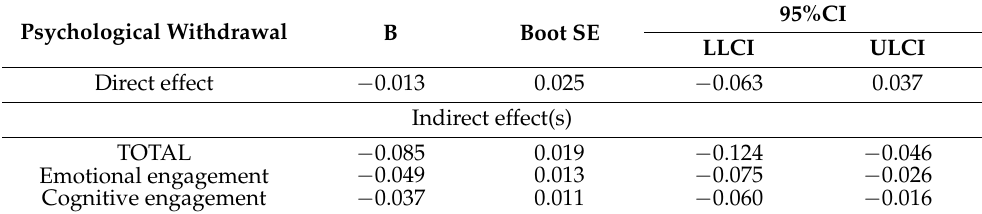
Figure 3. ( a ) Cross-level moderating effect of self-control on the relationship between emotional engagement and psycho- logical withdrawal. ( b ) Cross-level moderating effect of self-control on the relationship between cognitive engagement and psychological withdrawal.